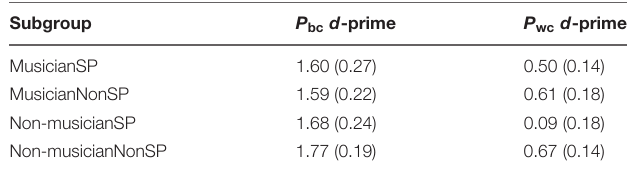
TABLE 2 | d -prime measures for discrimination of each subgroup (Musician and Non-musician Groups; Speech and Non-speech